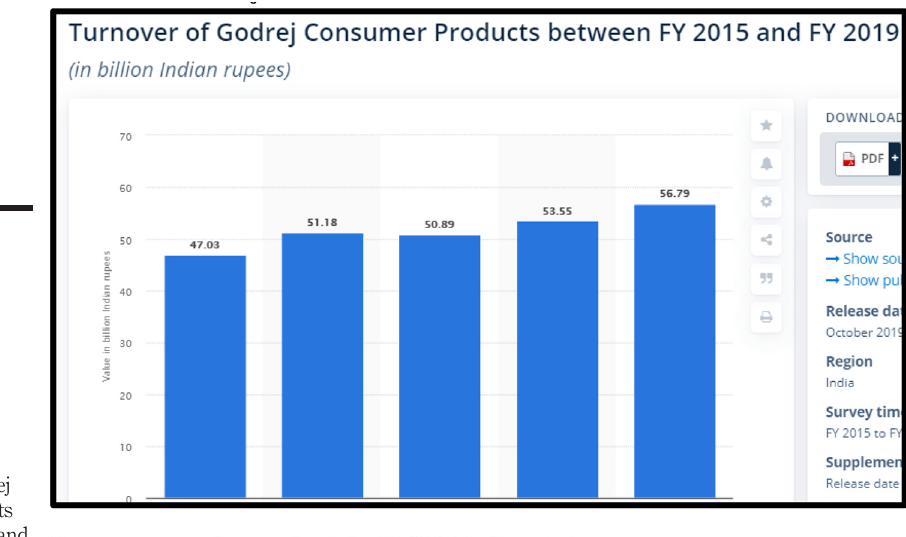
Figure 2. Turnover of